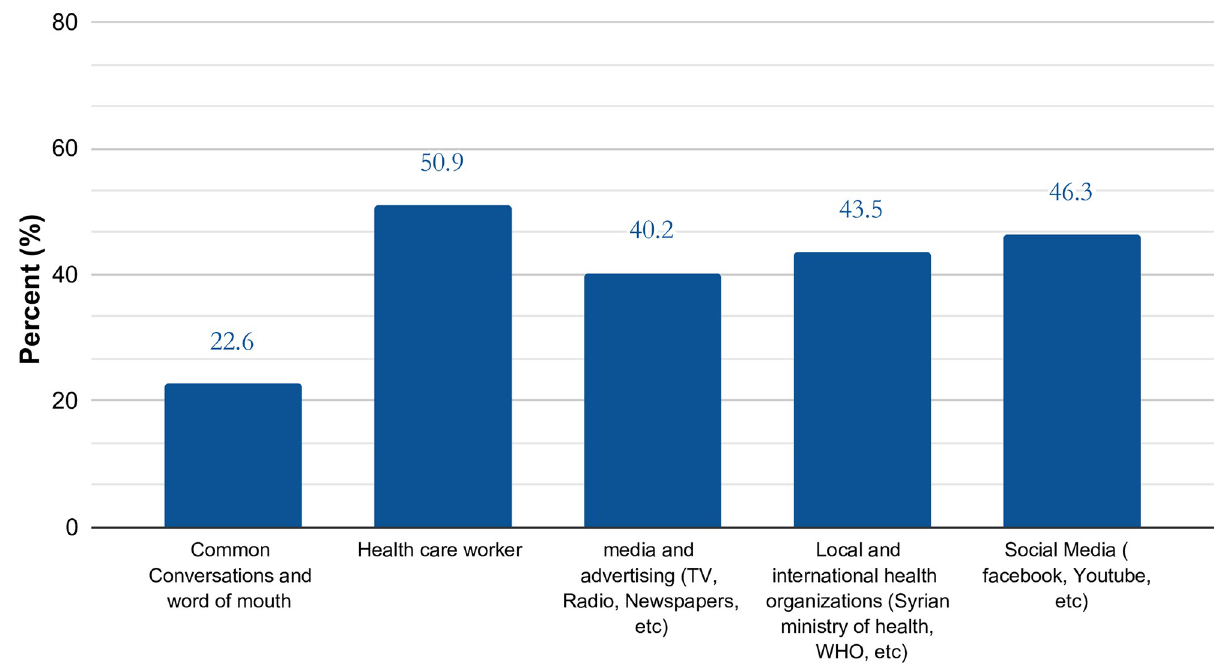
Fig 1. Participants sources of information.